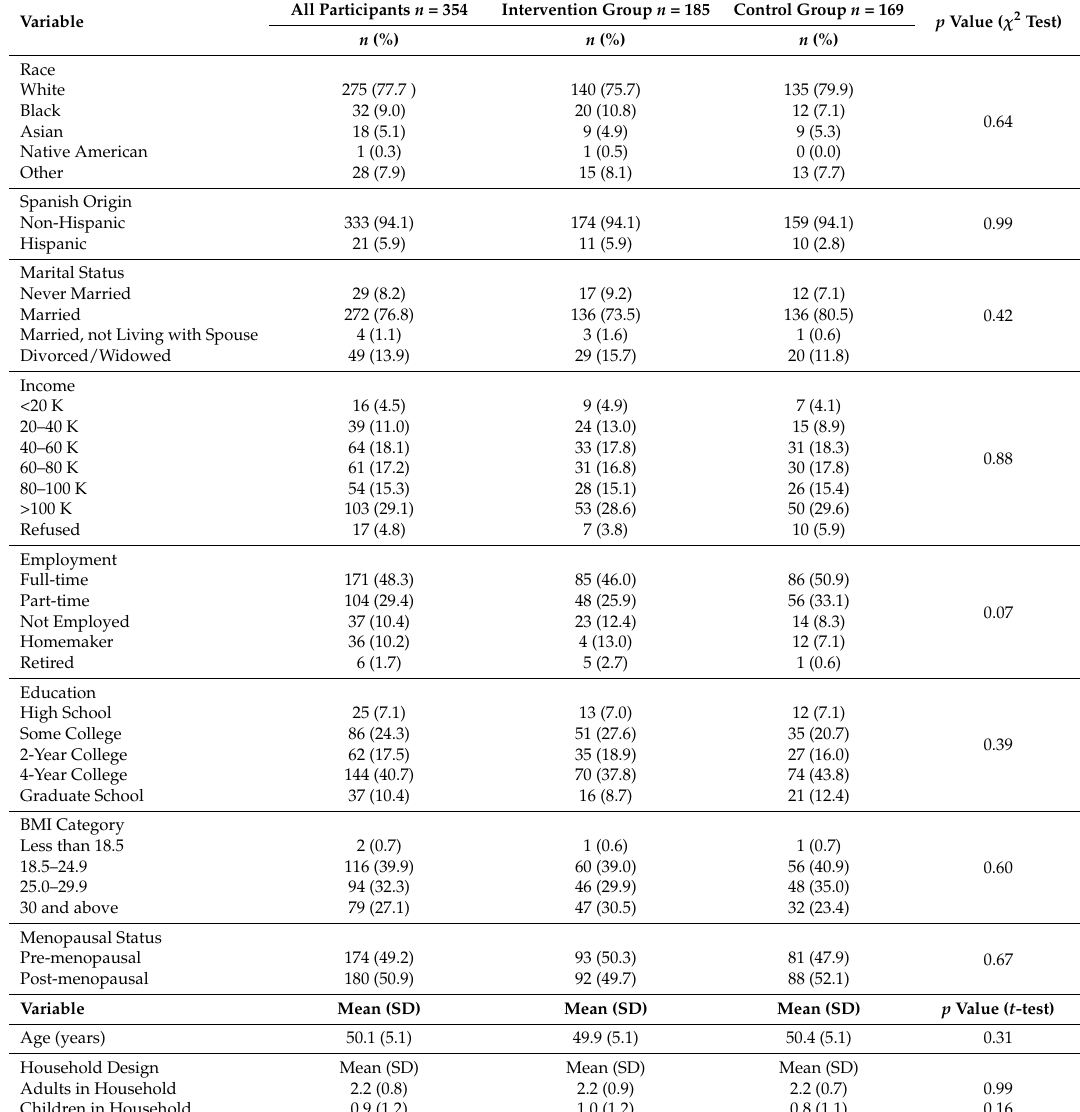
Table 2. Baseline demographic characteristics and weight status of all midlife women participating in a weight gain prevention study and by intervention and control